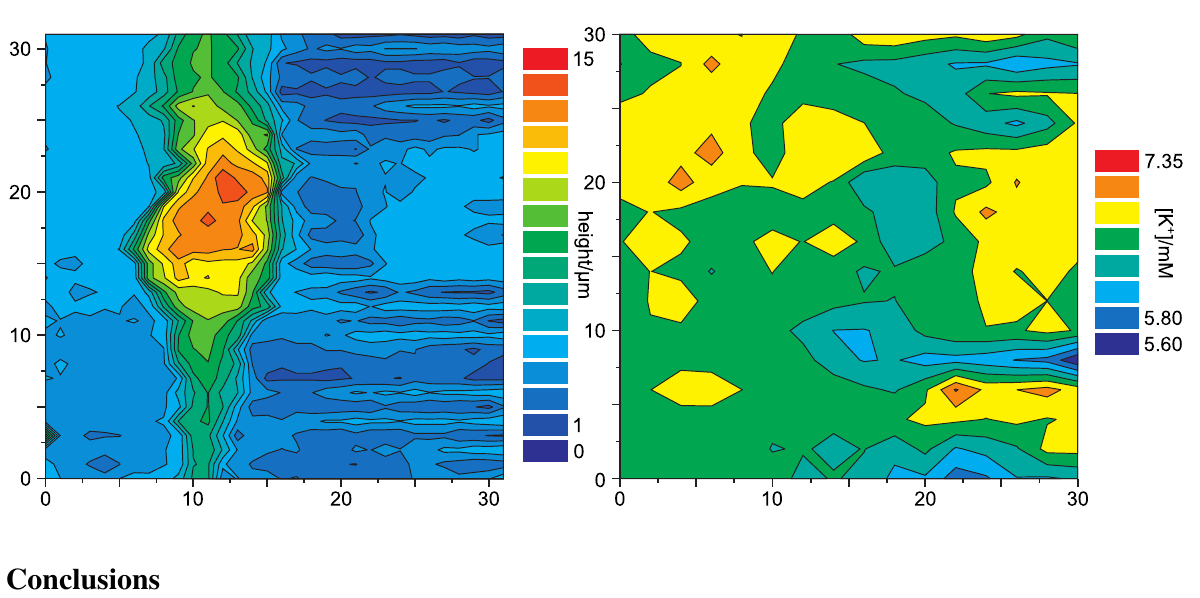
Figure 12. Color coded representations of the topography (left) and the surrounding K + activity (right) of a single cell from rat brain recorded by an ISME. Note, that the reference channel contained 1 mM glutamate to locally stimulate K +